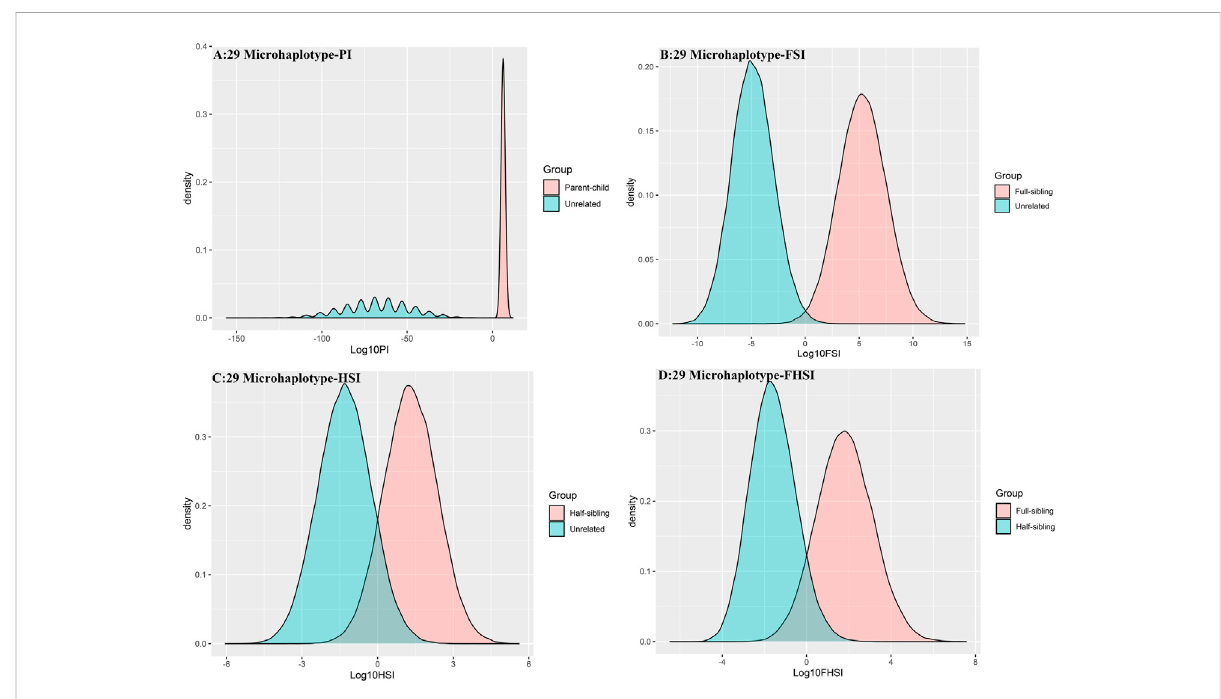
FIGURE 3 The distributions of Log 10 of PI, FSI, HSI and FHSI based on the data of 29 microhaplotype loci. (A) PI; (B) FSI; (C) HSI; (D) FHSI.